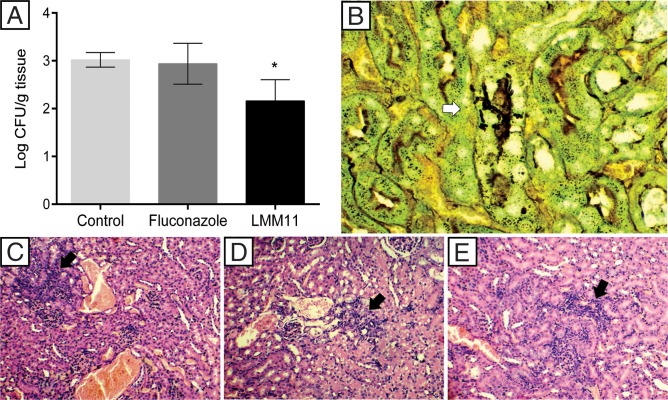
The in vivo efficacy of LMM11 in systemic C. krusei candidiasis.Mice were infected with C. krusei ATCC 6258 (1x106 cells) and separated into three groups (n = 5): control (treated with PBS and the diluent), FLC (treated with fluconazole at 5 mg/kg) and LMM11 (treated with LMM11 at 5 mg/kg). Drugs were given to the mice twice a day for 5 days via intraperitoneal injection. (A) Colony forming units (log10 CFU) per gram of kidney. LMM11 significantly reduced the renal fungal burden in relation to the control and FLC (*p<0.05). The bars indicate the standard deviation. (B) Kidney histological sections after Gomori-Grocott staining to indicate the presence of yeast (white arrow) only in the control group. (C-E) Histological sections stained with hematoxylin and eosin showing inflammatory infiltrate (black arrow) in the control (C), FLC (D) and LMM11 (E). Representative kidney histopathological sections from 5 mice per group.